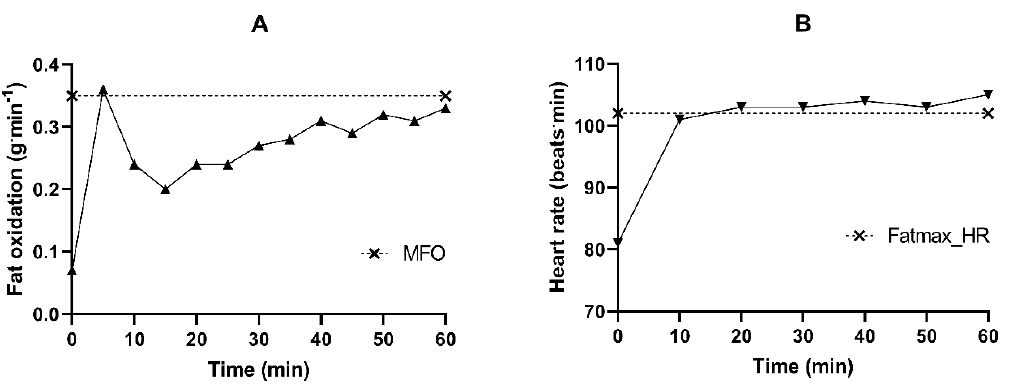
Figure A4. Whole-body fat oxidation ( A ) and heart rate ( B ) kinetics during 60 min of walking at fatmax on a treadmill. Own data obtained from a 60 min fatmax test: gas exchange (indirect calorimetry) and heart rate (heart rate wireless monitor) was registered during the entire exercise session. The session was divided into 5-min intervals; thus, VO 2 and VCO 2 average (last 120 s of each stage) was used to calculate fat oxidation with Frayn equation ( ( VO 2 × 1.67 ) − ( VCO 2 − 1.67 ) . Institutional Ethics Committee approved the experimental procedures before the test was realized.